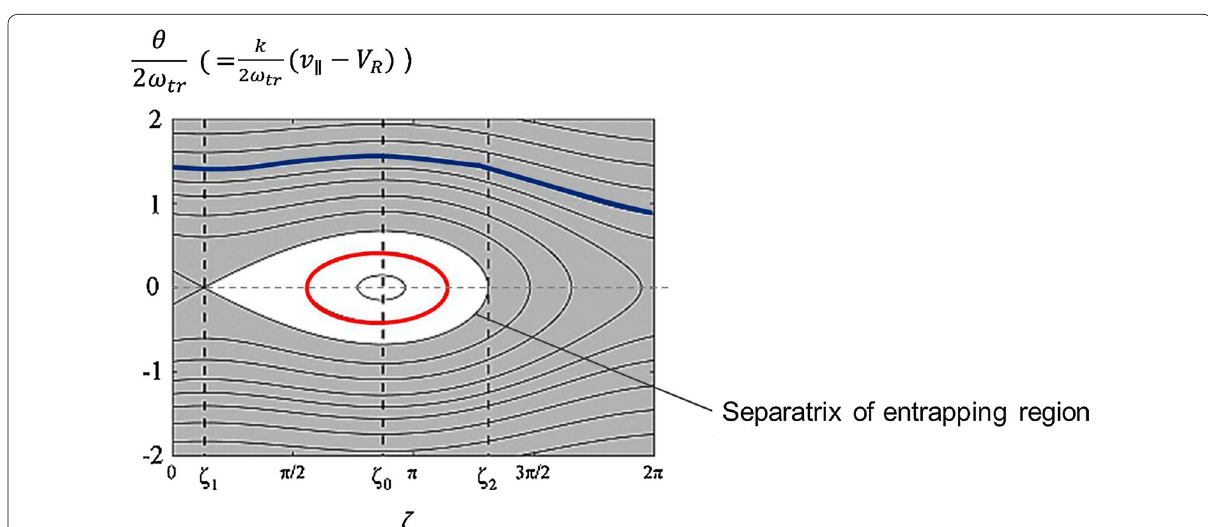
ζ ) phase space for S 0.4. The phase ζ of non-resonant electron oscillates between 0 and 2 − = − 0 ) draws closed trajectories (red trajectory). The region where electrons V R or θ ∼= � ∼=